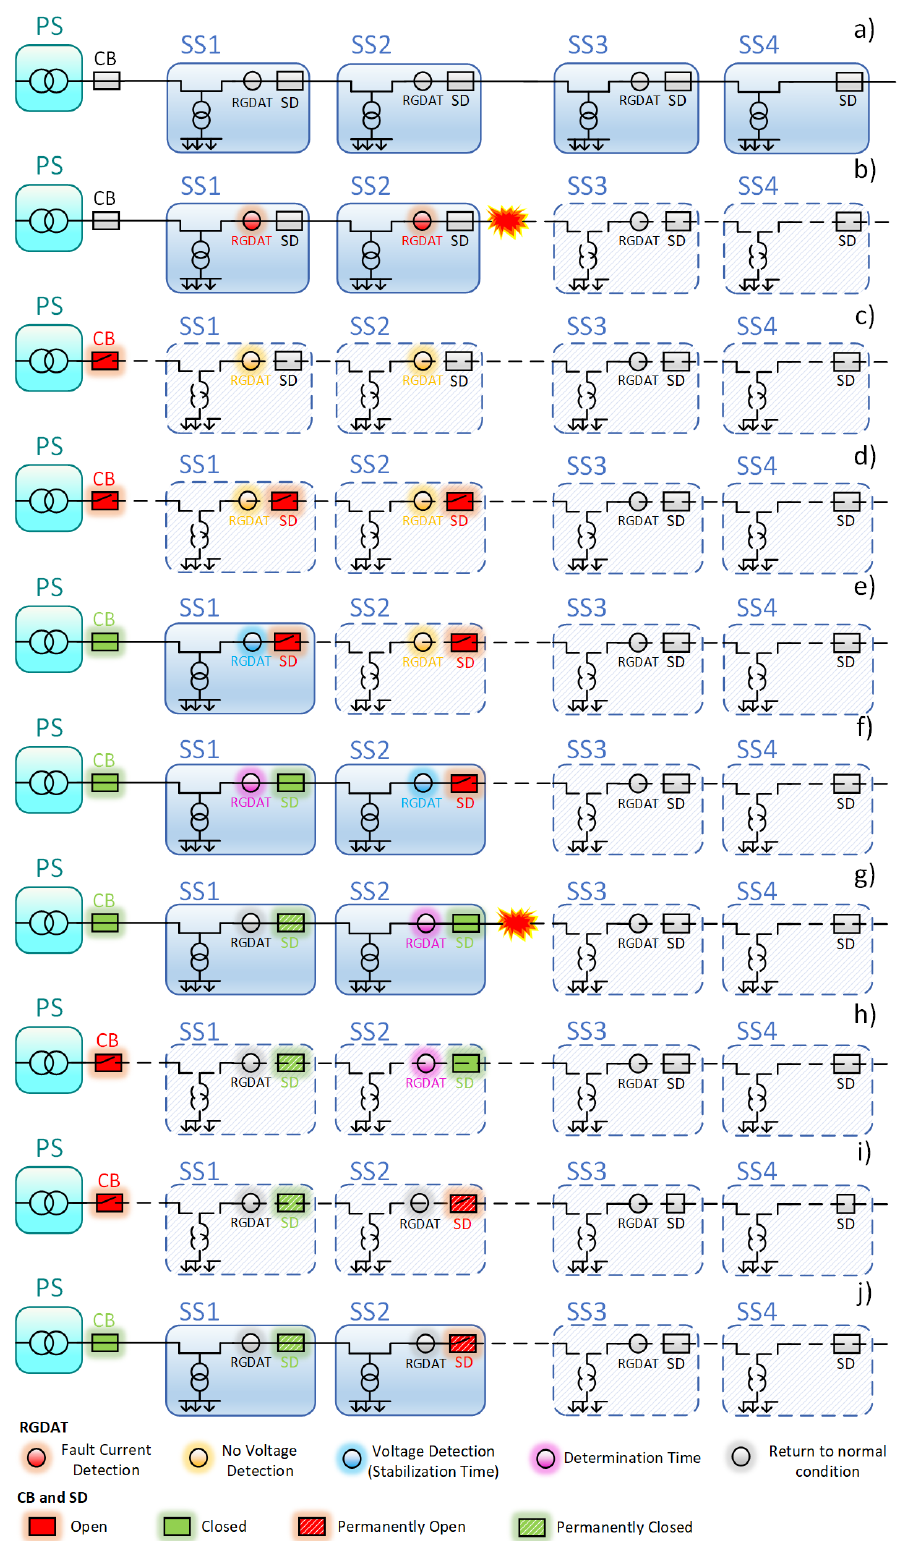
Figure 1. Automation steps according to the FRG approach; ( a ) normal operation, ( b ) fault occurrence, ( c ) CB opening, ( d ) SDs opening, ( e ) CB closing, ( f ) SD of SS1 closing, ( g ) SD of SS2 closing and fault current detection, ( h ) circuit breaker opening, ( i ) SD of SS2 opening, ( j ) CB closing and fault